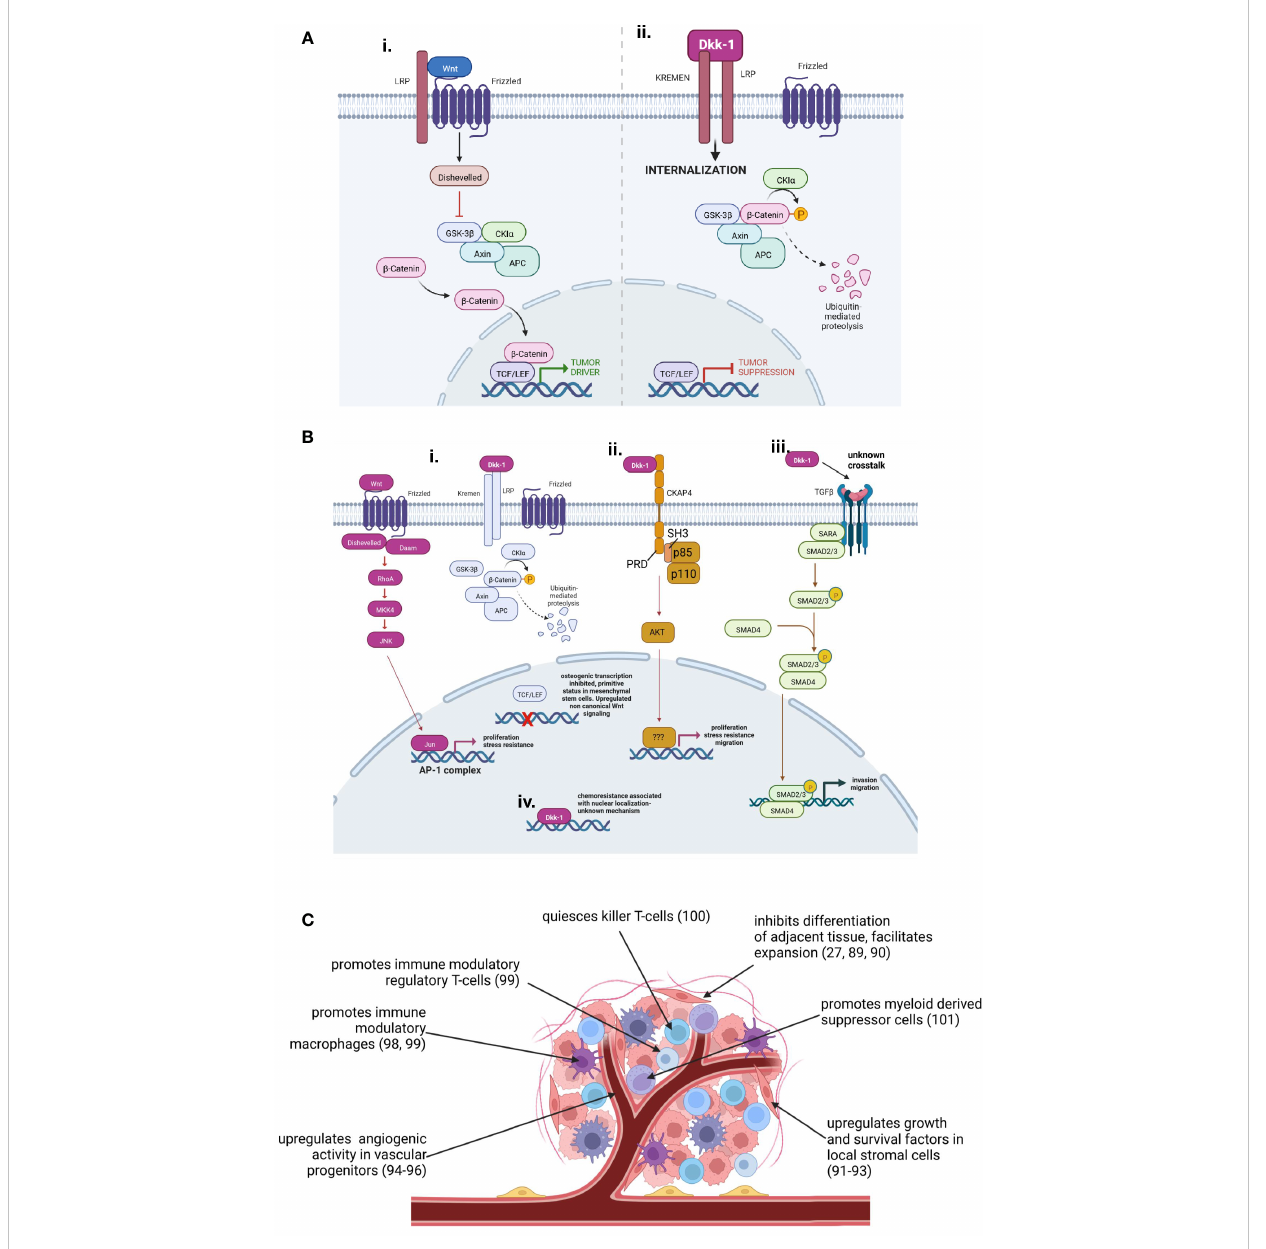
FIGURE 3 Tumor driver and suppressor roles adopted by Dkk-1. (A) : Dkk-1 acts as a tumor suppressor by inhibiting proliferative cWnt signaling. (B) : Tumor driver mechanisms of autocrine Dkk-1 activity. (Bi) : Dysregulation of balance between cWnt and ncWnt mechanisms in favor of ncWnt-mediated tumor survival pathways (e.g. ref: 27 – 30). Differentiation pathways mediated my cWnt may be affected, predisposing tumor cells to a more primitive, malignant phenotype (e.g. ref: 27, 85). (Bii) : Dkk-1 engages the CKAP4 receptor triggering PI3kinase and AKT activation resulting in enhanced proliferation, survival and migratory capacity (e.g. ref: 26, 86). (Biii) : Dkk-1 participates in synergistic crosstalk with TGF b enhancing invasion and migratory capacity (e.g. ref: 14, 24). (Biv) : Dkk-1 interacts with nuclear components enhancing expression of survival factors that facilitate chemoresistance (e.g. ref: 87). (C) : Paracrine roles for Dkk-1 as a tumor driver modulating angiogenesis, immunoregulation, host tissue architecture and secretion of survival factors by stromal cells. Diagrams created by